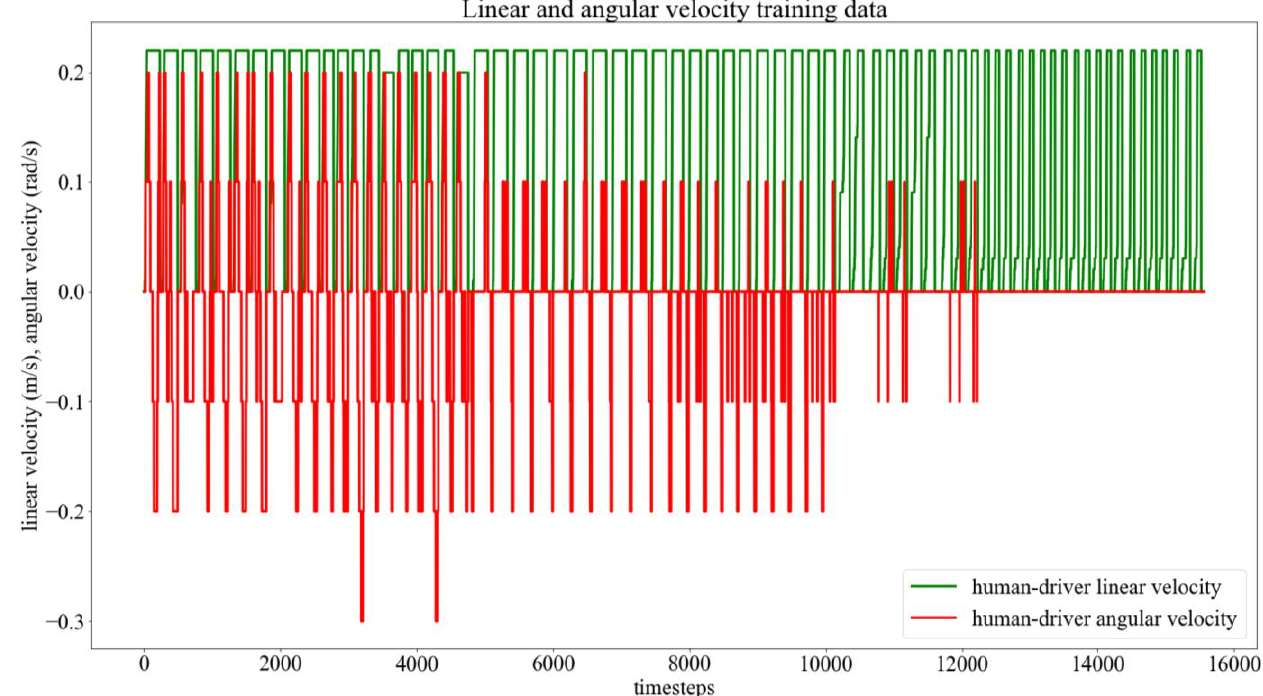
Figure 10. Velocity commands for several trajectories given by the user for training.